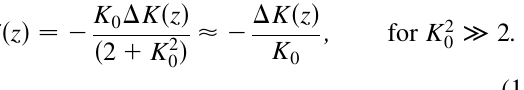
at z (cid:1) 40 m x